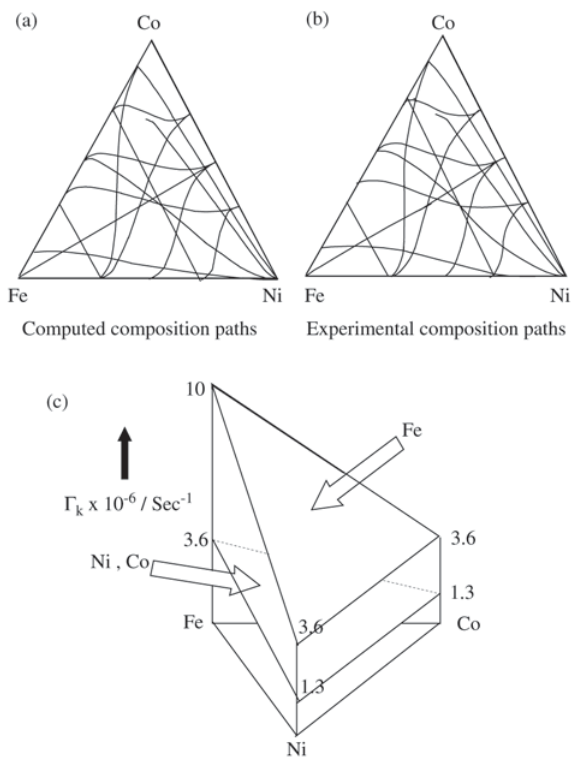
Figure 14. Comparison: a) simulated; b) experimental composi- tion paths in the Fe-Co-Ni system 43,44 ; c) The jump frequency model employed for this simulation 44